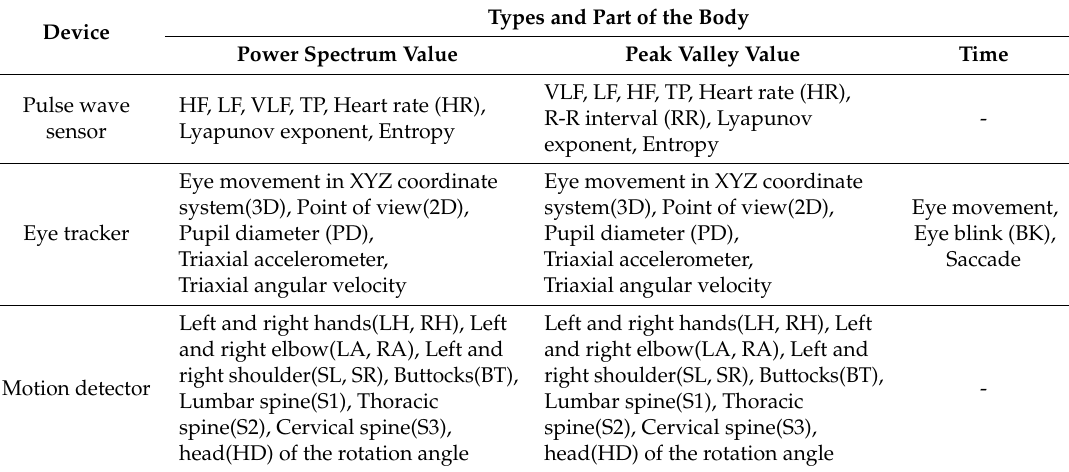
Table 2. Time series features are calculated from time series data acquired with wearable